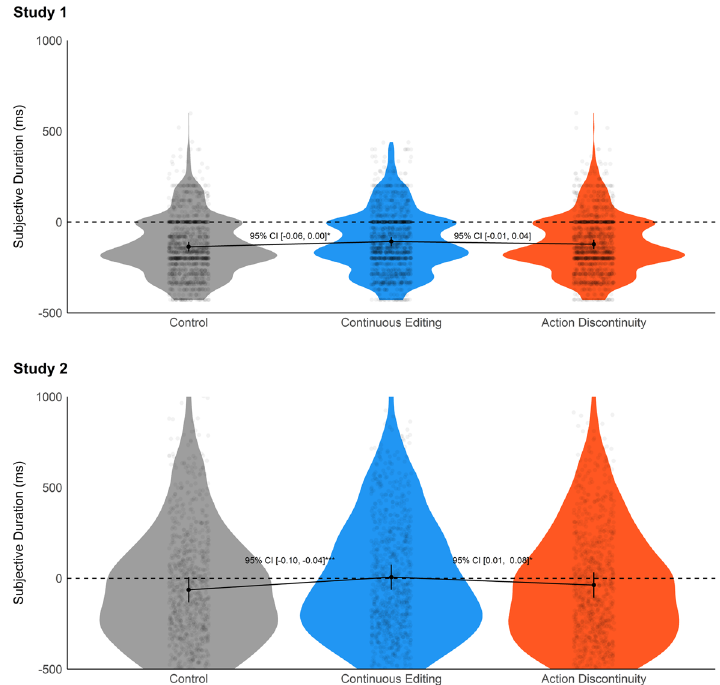
Figure 1. Time estimation error for the three editing types. The picture represents the marginal means (estimated by mixed models) with data distributions and data points. Error bars represents 95% CI. The confidence intervals of marginal differences between conditions are reported between the conditions of interest. * p < 0.05, *** p <